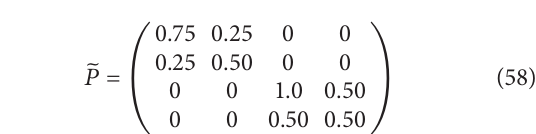
whose maximal eigenvalue 𝜆 max (𝐻) = 1.309 . From (45), still take 𝑘 = 1.5 .